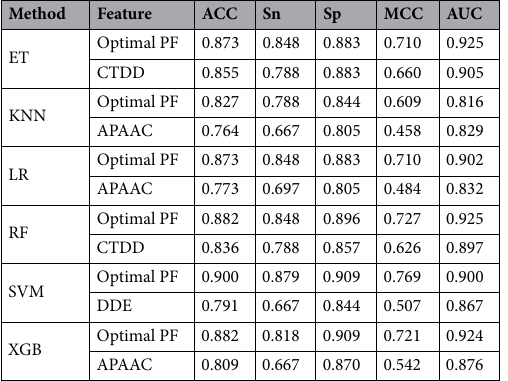
Table 5. Performance comparison of new feature representation with conventional sequence-based feature descriptors as evaluated on the independent test.